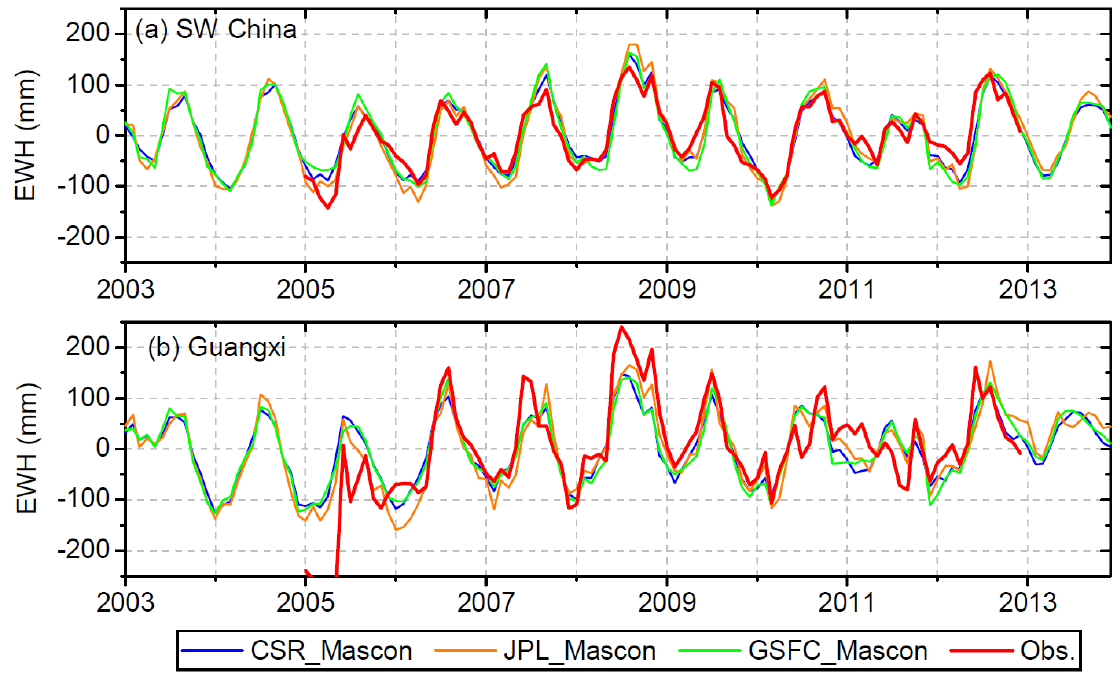
Figure 8. Comparison of mascon-based TWS with in situ observations.